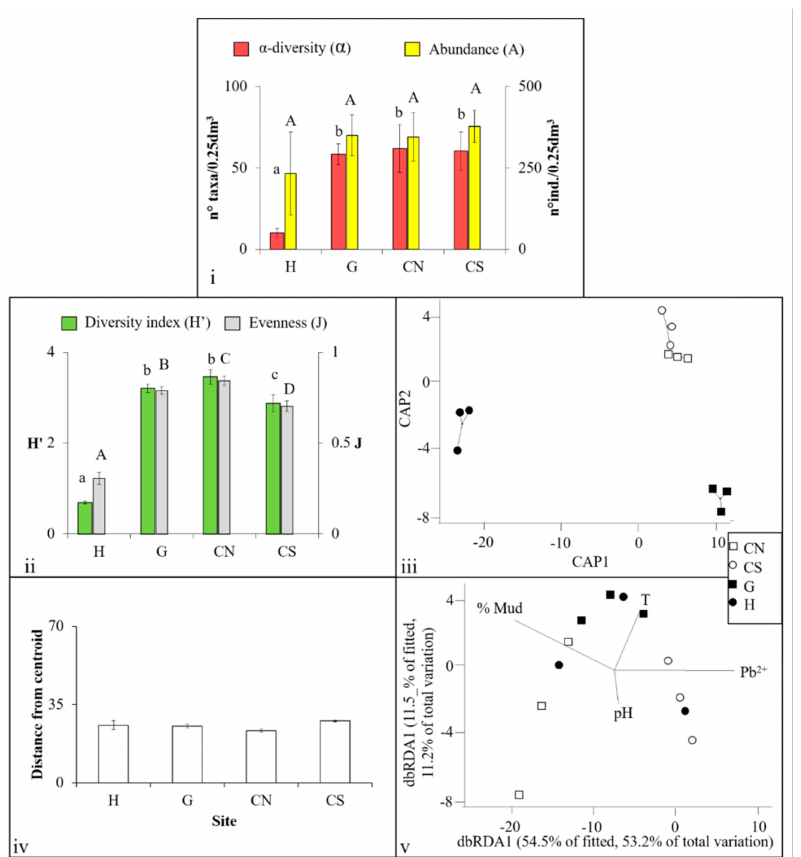
Figure 8. ( i ) α -diversity ( α ) and abundances (A) trends of Nematoda assemblages, ( ii ) Diversity (H’) and evenness (J) indices trends of Nematoda assemblages. Bars with di ff erent letters (a, b) are related to sites showing significant differences ( p < 0.05). ( iii ) CAP for the factor Site: straight lines are related to distances of each site replicates from their cluster centroid, formally explained in ( iv ): mean ( ± SE) multivariate dispersion (PERMDISP, small-scale heterogeneities) of the Nematoda assemblages calculate on their abundances. ( v ) The dbRDA (distance-based redundancy analysis) ordination for Nematoda heterogeneities vs. the significant explanatory environmental variables. Vector overlays represent multiple partial correlations of the explanatory variables with the dbRDA axes. See text for further